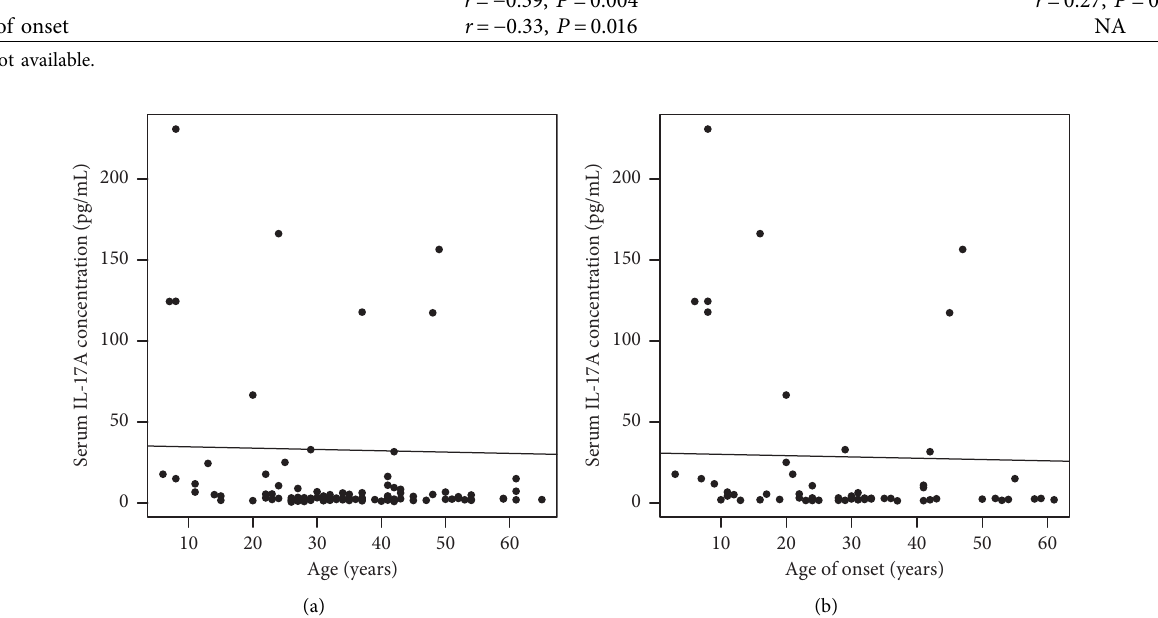
Figure 2: The correlations of serum IL-17A levels with age (a) and age of onset (b) in vitiligo